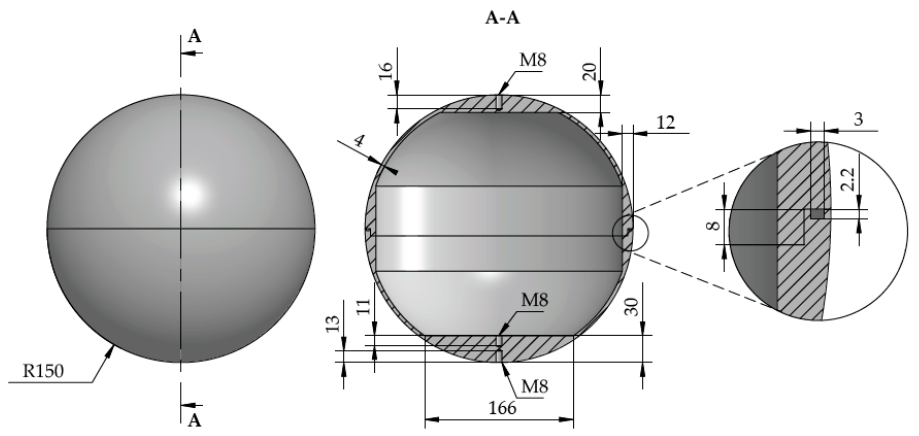
Figure 4. Technical drawing of the two hemisphere shells. Measurements are in mm.